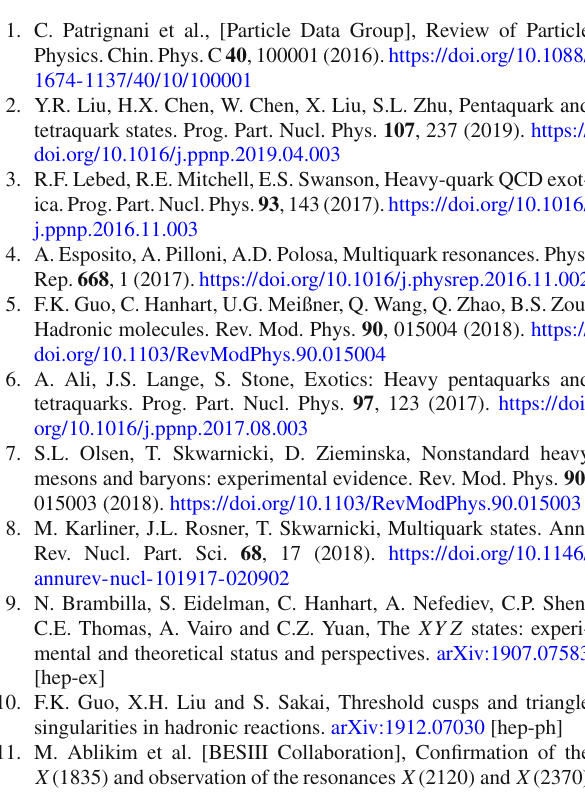
Fig. 6 Mass calculated using the current J 2 , as a function of the threshold value s 0 (left) and the Borel mass M B (right). In the left panel the short-dashed/solid/long-dashed curves are obtained by set-